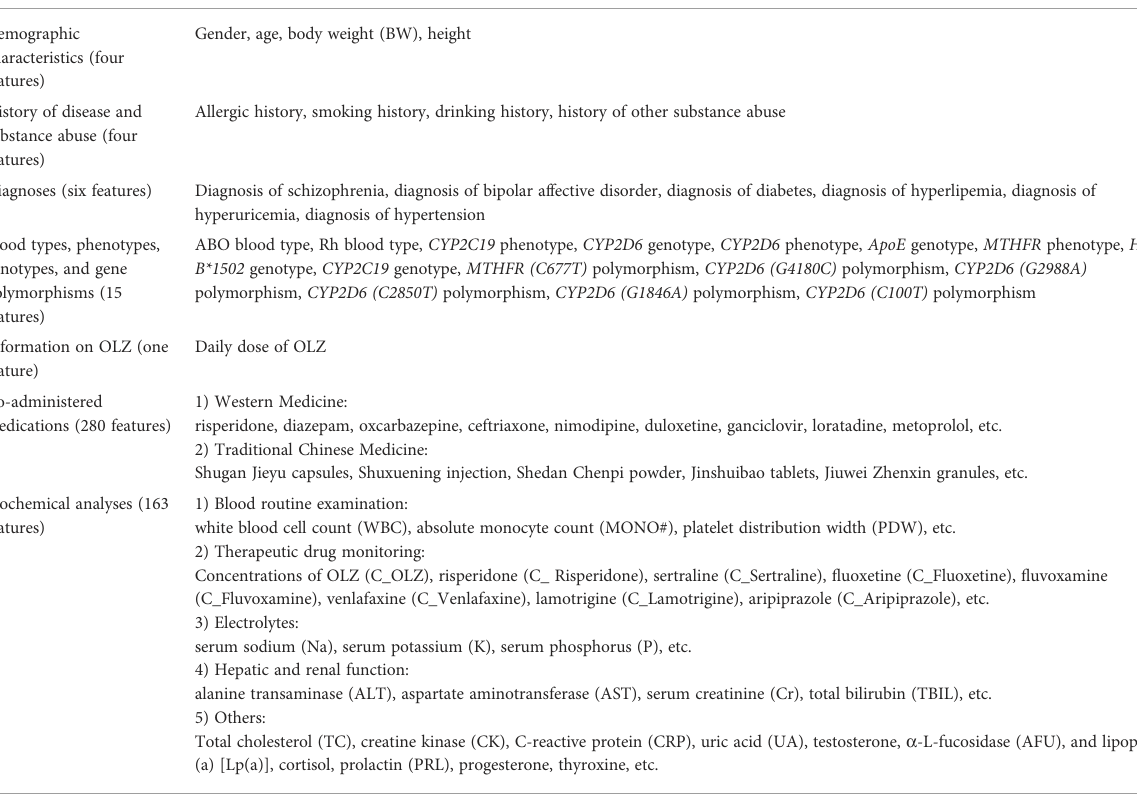
TABLE 1 A summary of the features of patients taking olanzapine (OLZ) in our original data derived from the EHR system.